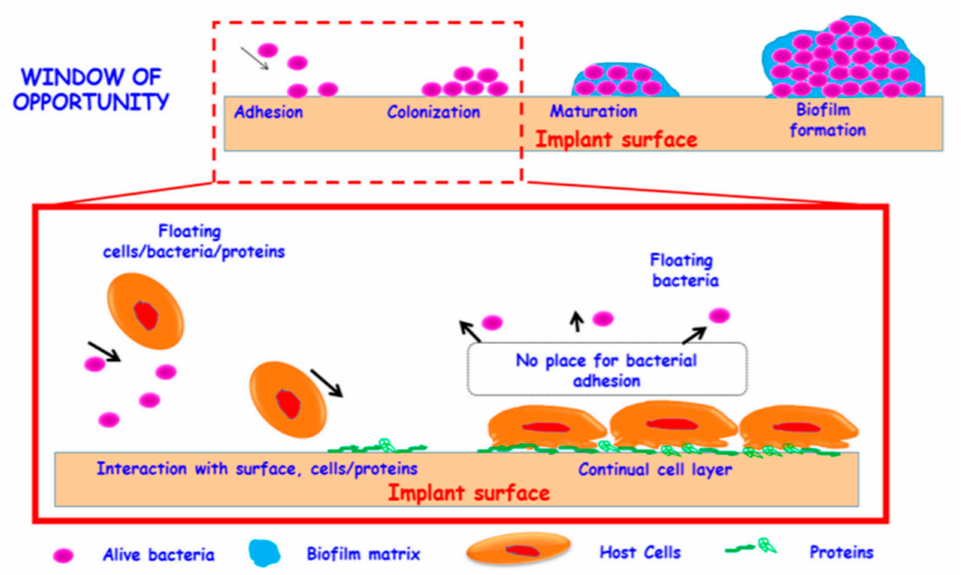
Figure 5. Schematic representation of biofilm formation on an implant surface. The process involves four steps: (1) bacterial adhesion, (2) bacterial growth, (3) maturation and (4) biofilm formation. In addition, bacteria may leak out from the matrix and lead to bacterial dispersion. The first stages constitute a window of opportunity, in which it is still possible to prevent biofilm formation. Reproduced from [40] with permission of MDPI,